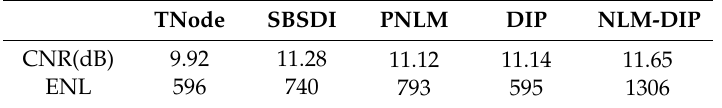
Table 2. Metrics comparison of different despeckling algorithms on the real dataset.